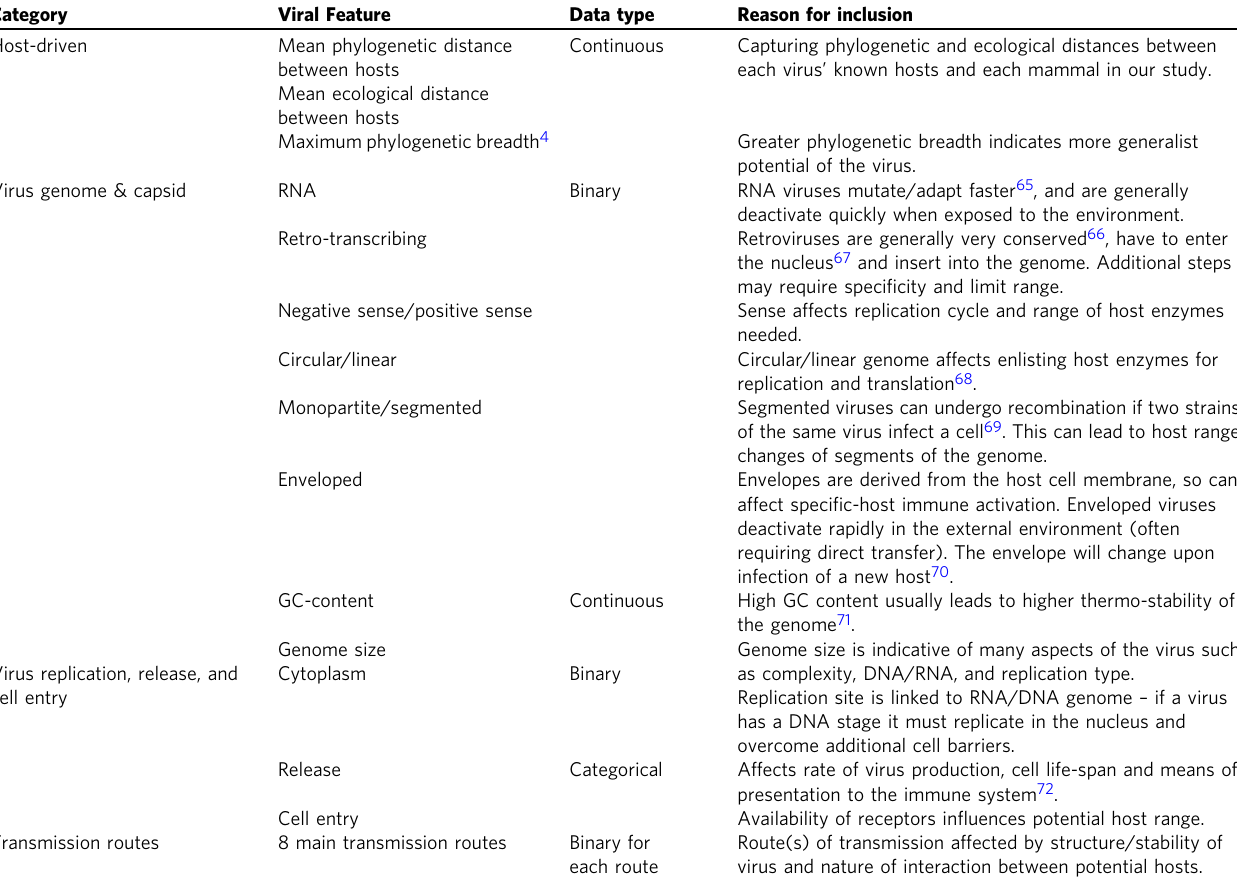
Table 1 Viral traits & features used to build our mammalian models.